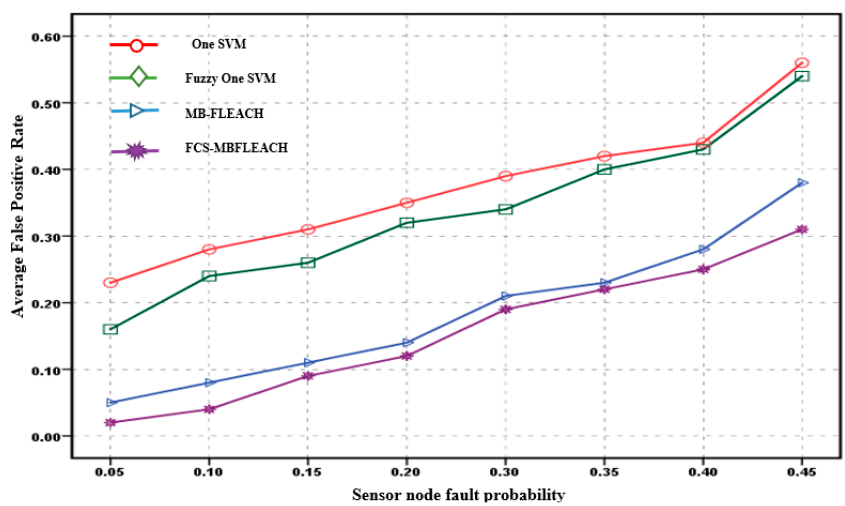
Figure 13. Average false positive rate for sensor node faults with a density equal to 5 for the second scenario.